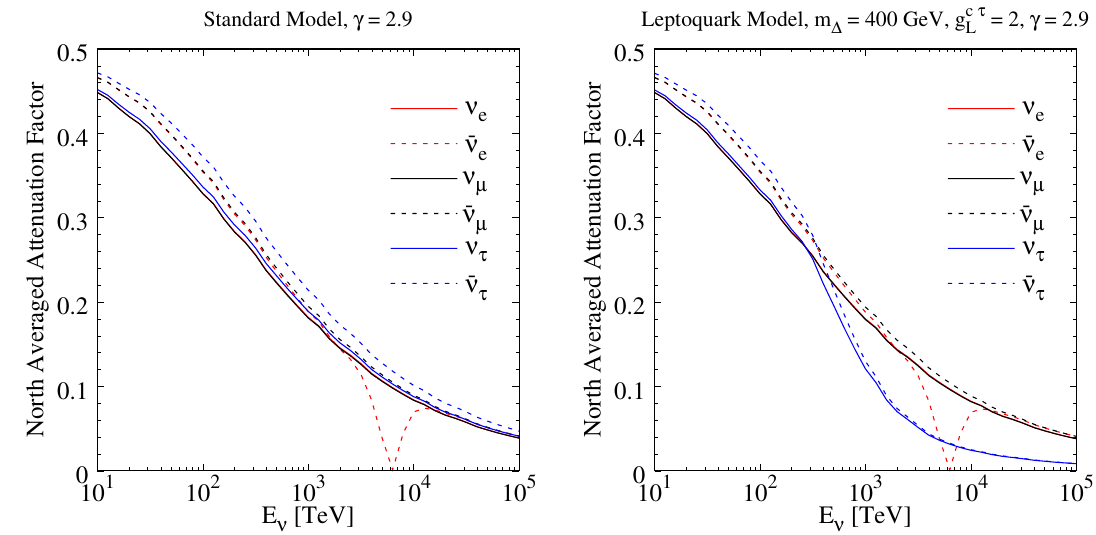
N ( E (cid:23) ) for each (anti-)neutrino (cid:13)avor for the SM (left (cid:11) A = 2 (right panel). These results has been L